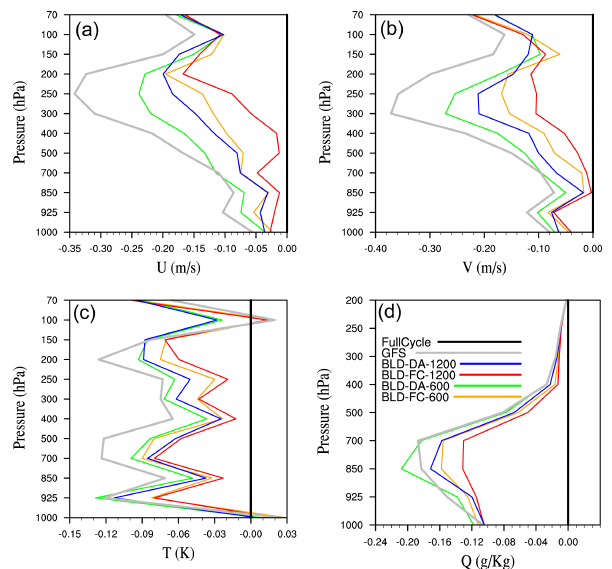
Figure 7. Same to Fig. 6 but for 24h RMSD reduction compared to the experiment FullCycle. (a) u , (b) v , (c) T , and (d) q .